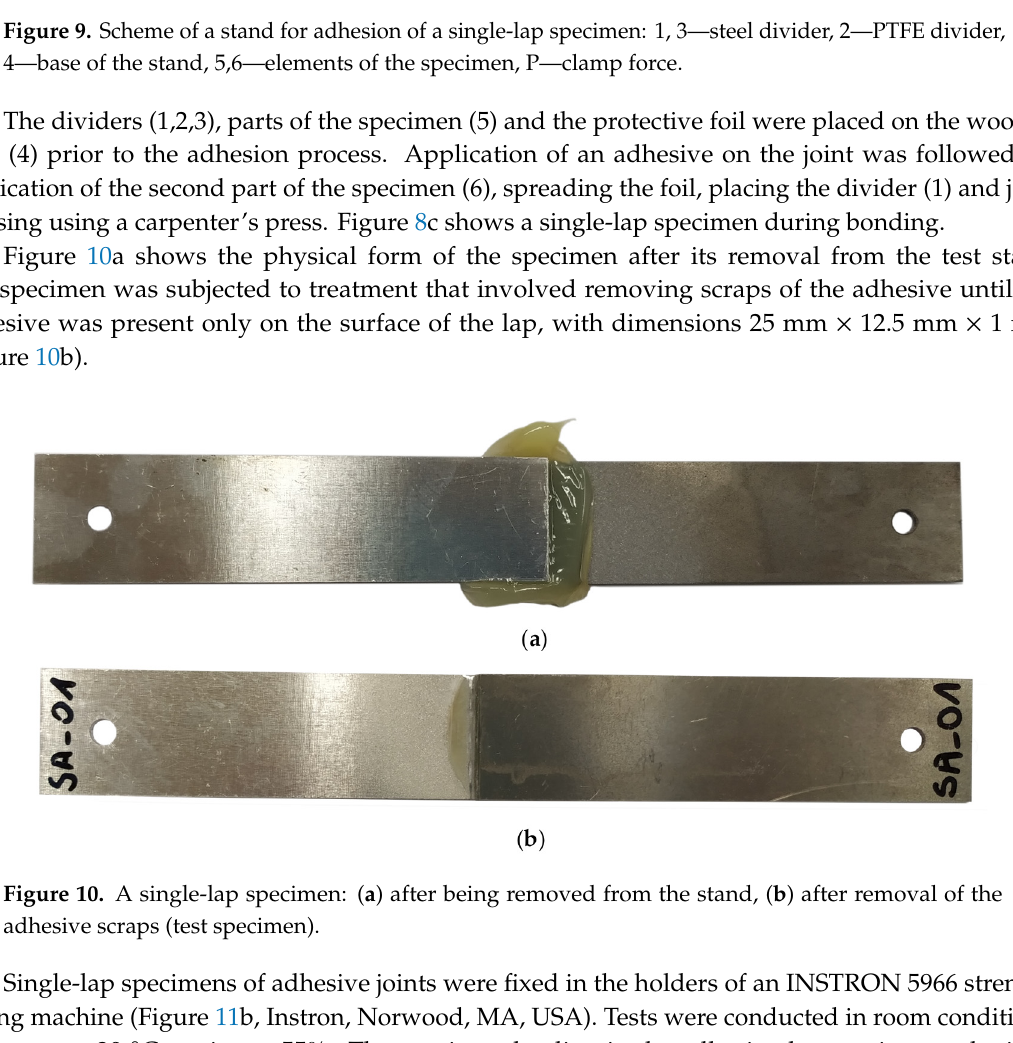
( b ) Figure 11. The way of the specimen montage in a holder of the strength testing machine: ( a ) scheme of montage: 1—specimen, 2—pad, 3—holder of the strength testing machine, ( b ) image of the test. Failure shear stresses are determined by their tension effect on single-lap adhesive joints. This calculation is performed by a simple engineering analytical method with an assumption of total stiffness, no strain of the adherend materials and zero thickness of the adhesive layer. Loading of the joint only causes strain in the adhesive layer. The value of shear stress τ in this method is described by dependence (Equation (1)):